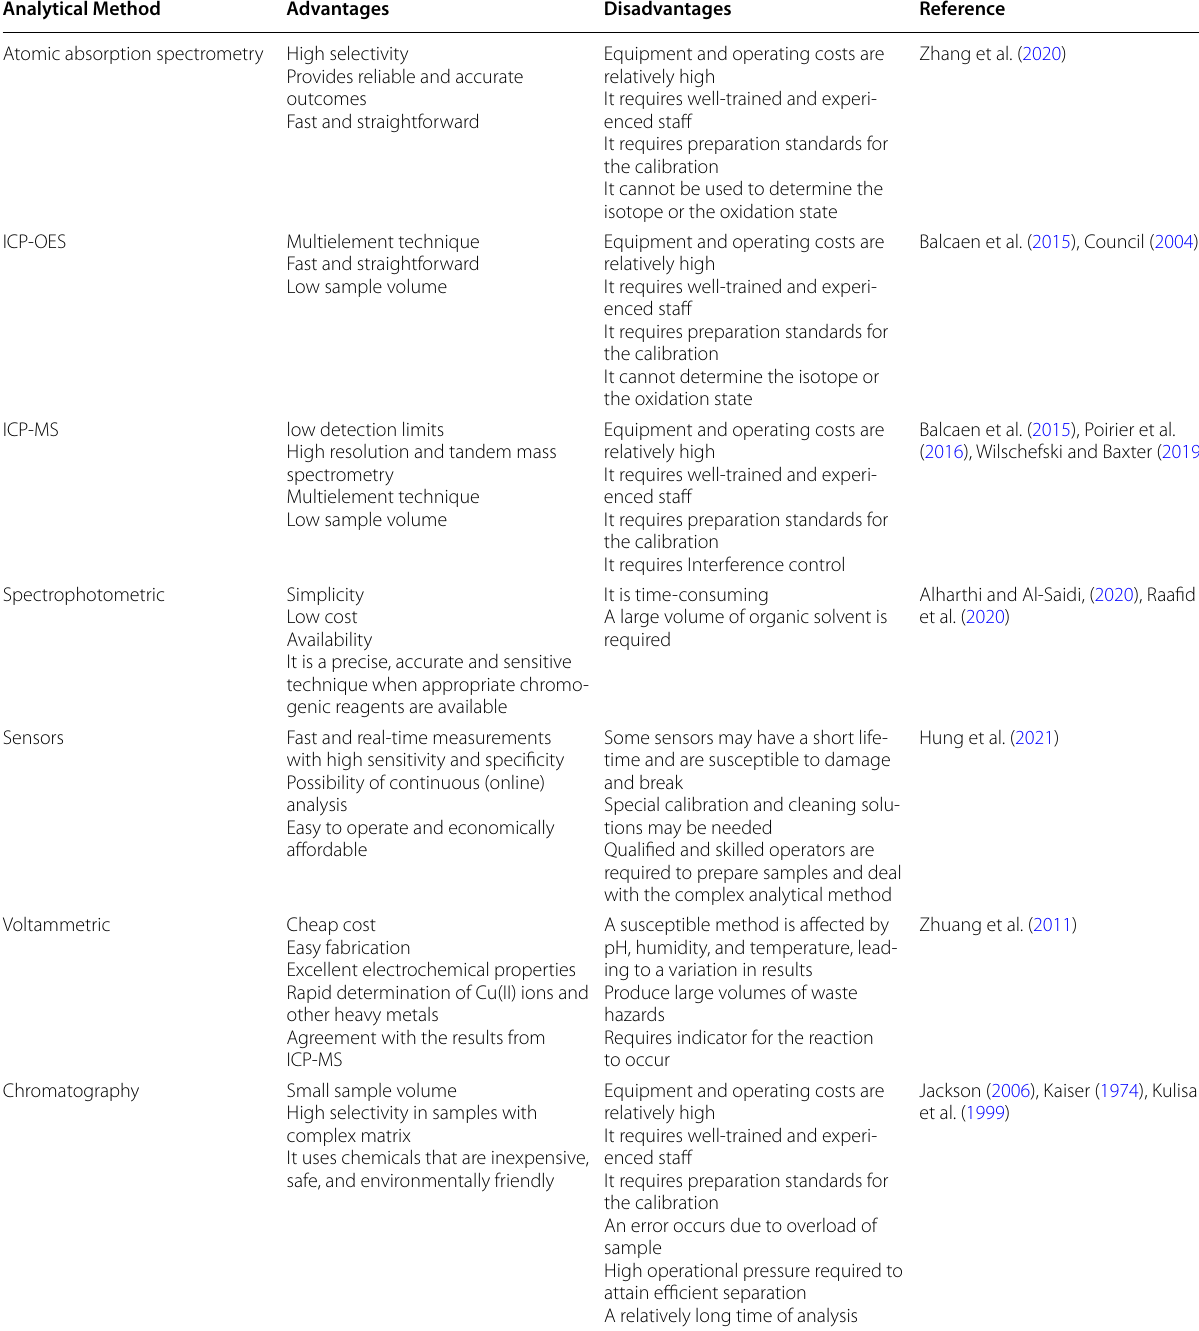
Table 5 Advantages and drawbacks of Cu(II) detection methods Analytical